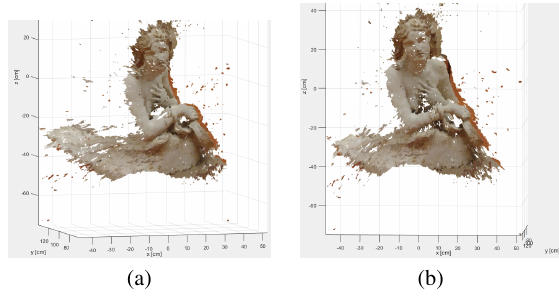
Figure 6. Two views of the 3D reconstruction obtained from the couple of stereo images shown in Fig. 4.